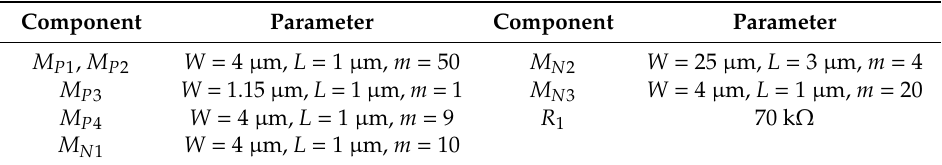
Table 1. Component